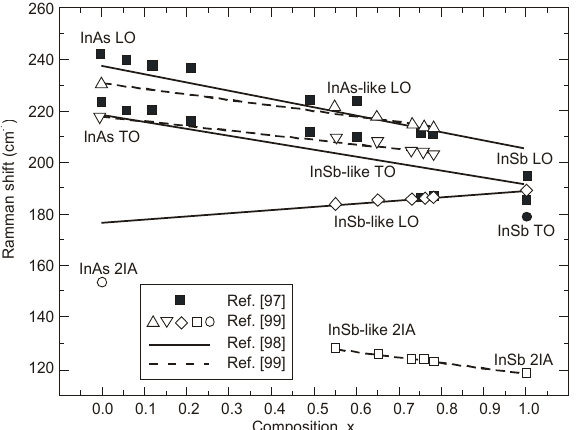
Figure 21. Intrinsic absorption coefficient for Hg 1 − x Cd x Te, InSb, and lattice-matched InAs 0.911 Sb 0.09 and InAs/InAsSb SLs at room temperature.